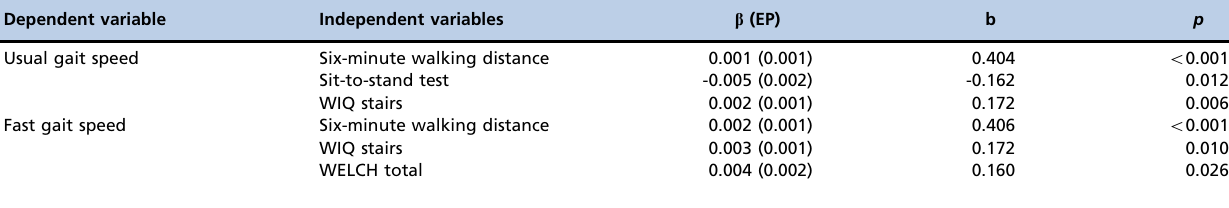
Table 3 - Adjusted associations between 4-meter gait speed test speed with objective and subjective measurements of physical function in symptomatic peripheral artery disease patients (n=169). Dependent